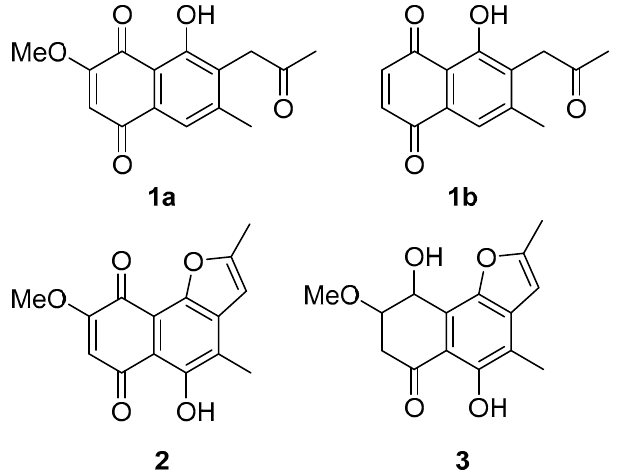
Figure 7. Structures of isolated compounds from Neocosmospora sp. MFLUCC 17-0253. ( 1a ) Mixture of 2-methoxy-6-methyl-7-acetonyl-8-hydroxy-1,4-maphthalenedione and ( 1b ) 5,8-dihydroxy-7-acetonyl-1,4-naphthalenedione, ( 2 ) anhydrojavanicin, and ( 3 ) fusarnaphthoquinones B.